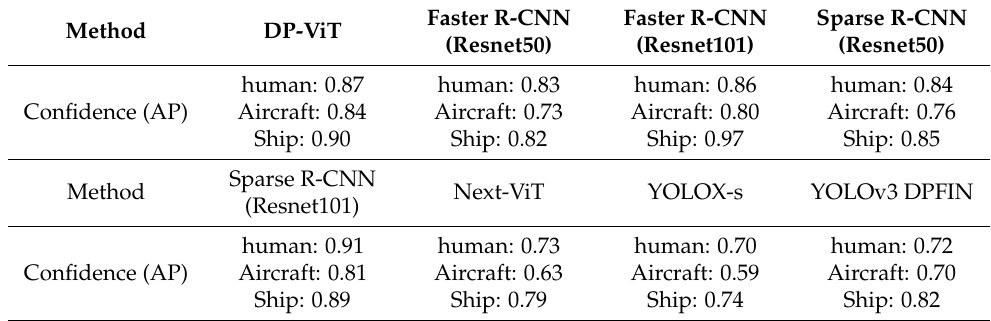
Table 3. Figure 7 Schematic test results.